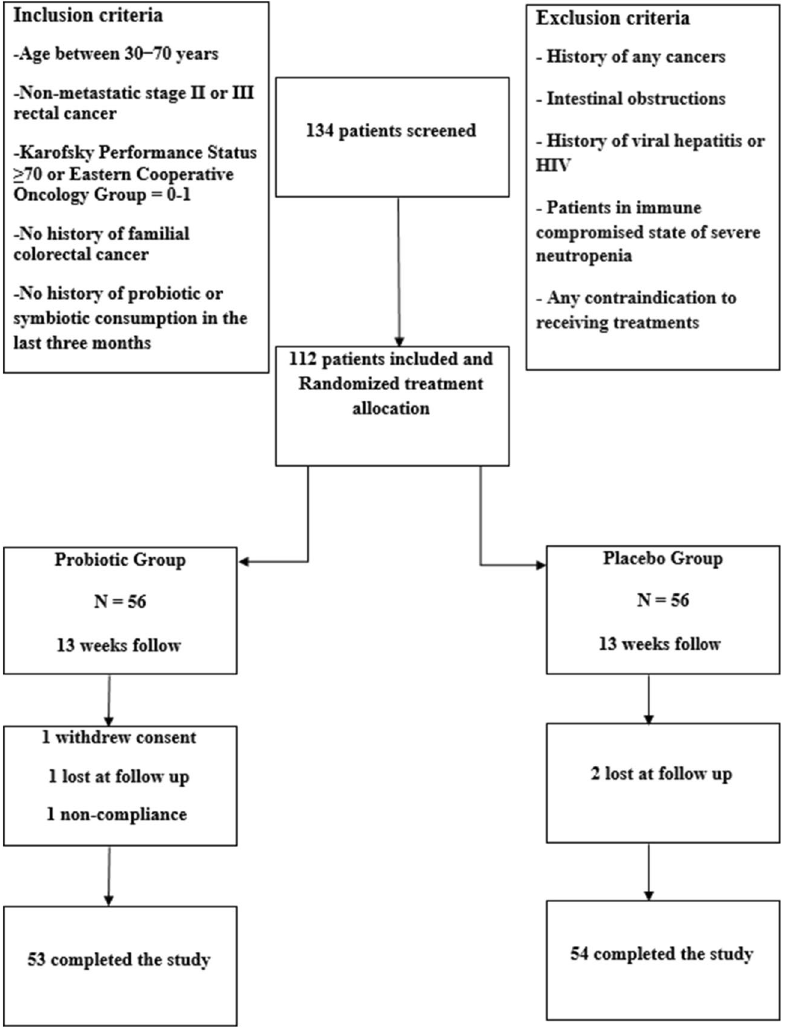
Figure 5. A flowchart of the present trial